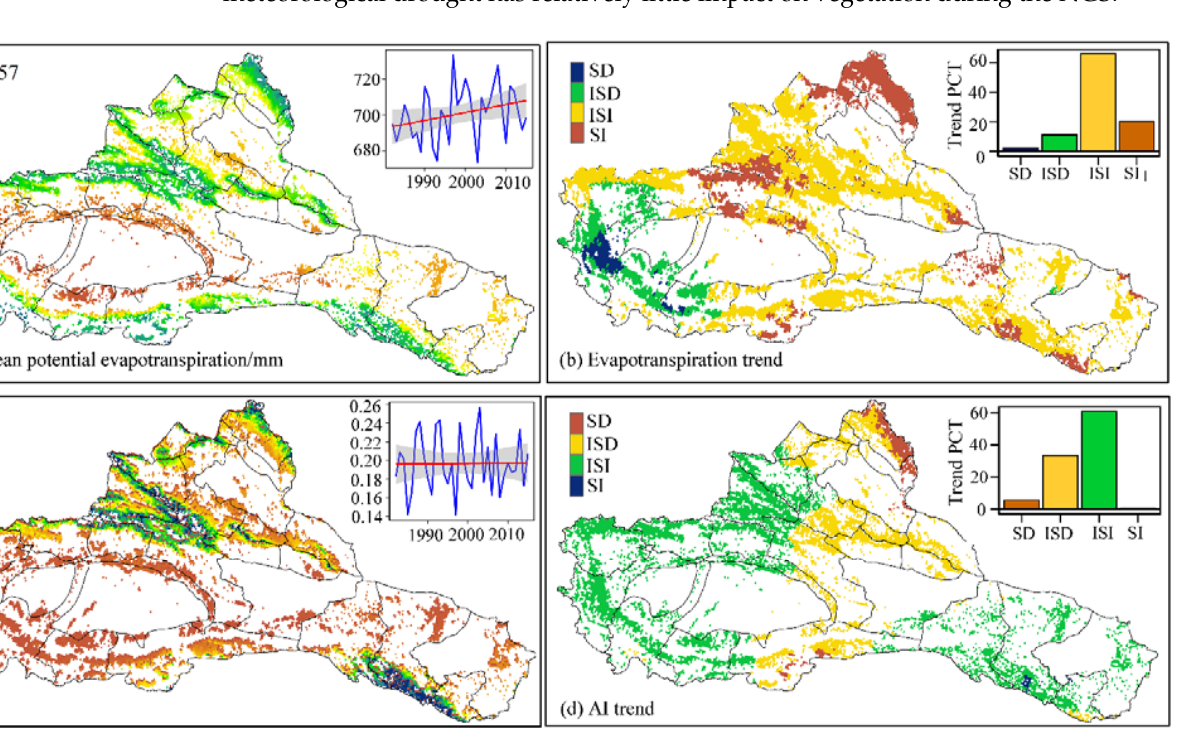
Figure 7. Mean ( a , c ), trends ( b , d ), and detrended correlations ( e , f ) between the Normalized Differ- ence Vegetation Index (NDVI) and aridity index (AI) in the arid region of northwestern China (SD, significantly decreasing trend; ISD, non-significant decreasing trend; ISI, non-significant increasing trend; SI, significantly increasing trend; SNC, significantly negative correlation; ISNC, non-signifi- cant negative correlation; ISPC, non-significant positive correlation; SPC, significantly positive cor- relation; GS, growing season; NGS, non-growing season).